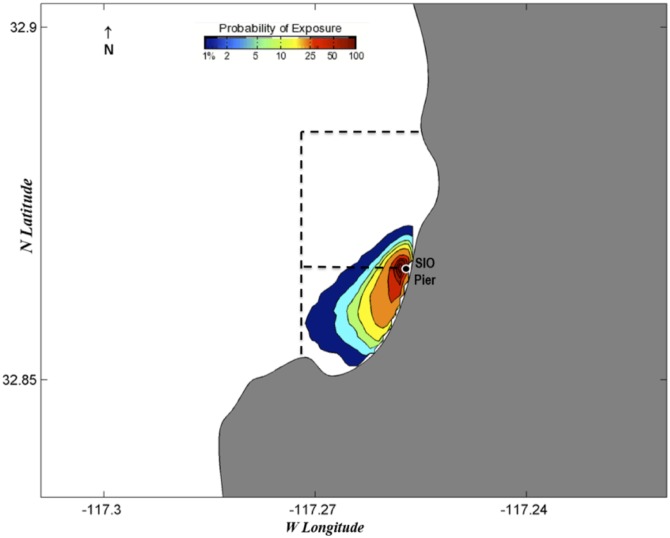
Probability map of predicted fish egg dispersal prior to collection: August 18–21, 2013.Dotted lines depict the boundaries of the MPAs: the San Diego-Scripps SMCA to the north and the Matlahuayl SMR to the south.